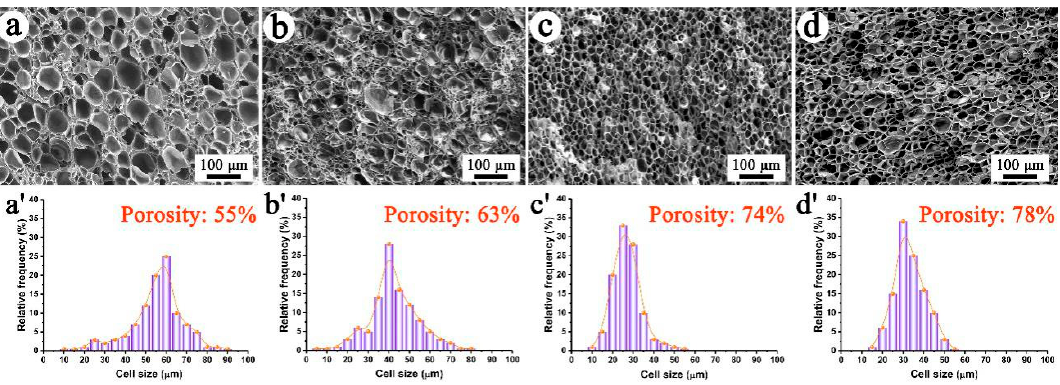
Figure 2. SEM images and cell size distributions of foams ( a ) neat PP, ( b ) PP/FKM(0.5), ( c ) PP/FKM(1.0), and ( d ) PP/FKM(2.0), all prepared at 152 °C and 20 MPa.